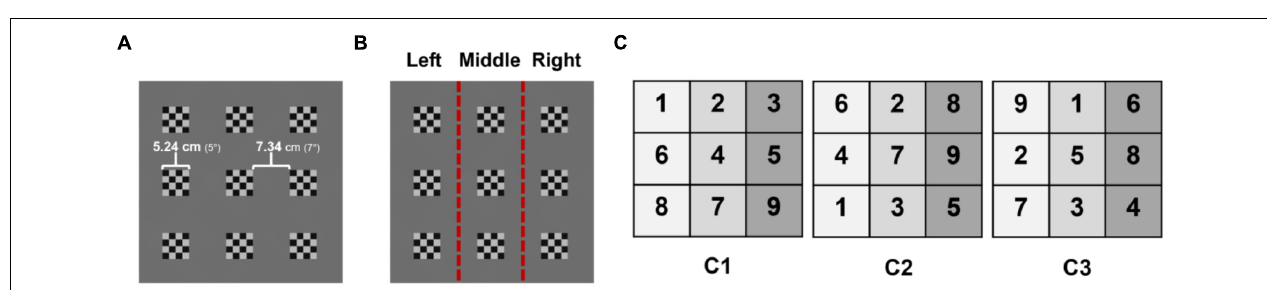
FIGURE 3 | Schematic diagram of a single trial in the experimental paradigm.